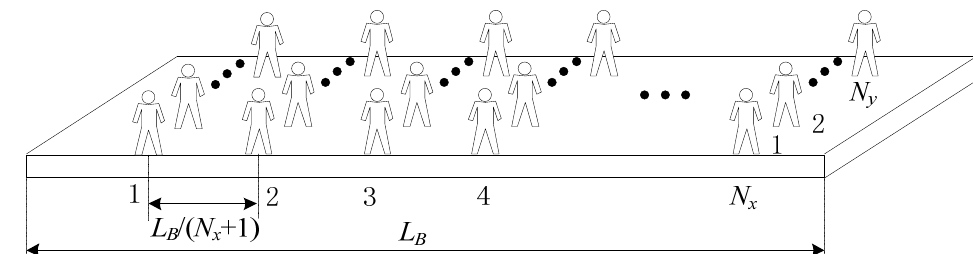
Figure 2. Diagram of a uniformly arranged crowd on a footbridge.